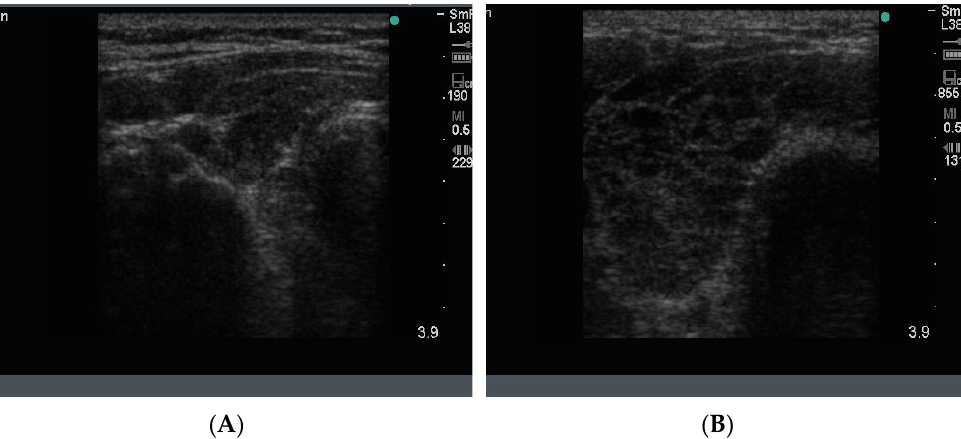
Figure 16. Thyroid ultrasound findings in 2 patients with different features of late-stage Hashimoto thyroiditis. In ( A ) the dominant feature is diffuse hypo echoicity, seen as black “holes” indicating the absence of thyroid tissue, some scarring, decreased vascularity and architectural damage in an overall enlarged gland. In ( B ), the thyroid gland is now shrunken, scarred and shrivelled with pseudo nodules and scattered fibrous bands in a small gland; this is the final stage and the patient has no thyroid function.